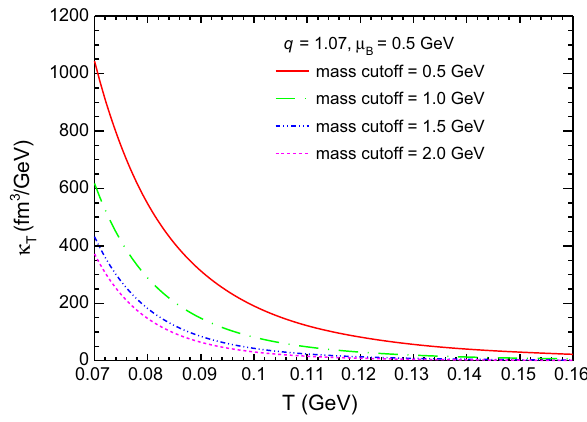
0.07 0.08 0.09 0.1 0.11 0.12 0.13 0.14 0.15 0.16 T (GeV) Fig. 8 Isothermal compressibility as a function of temperature for dif- ferent mass cutoff, with μ B = 0 . 5 GeV and q = 1 . 07